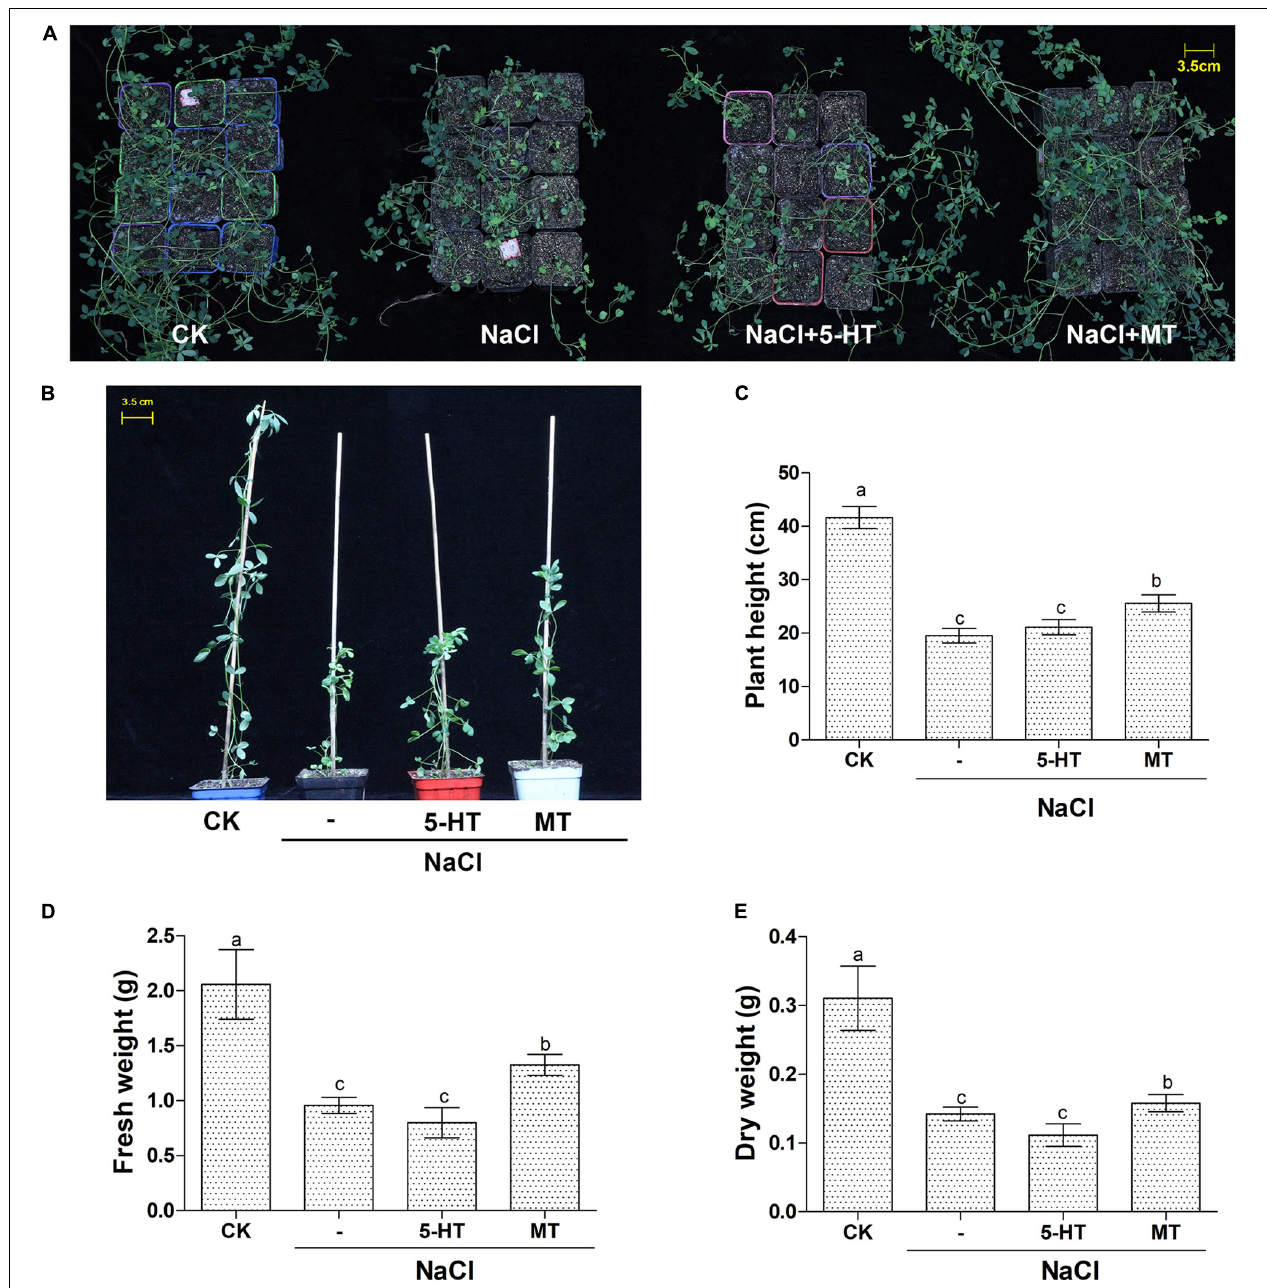
FIGURE 4 | Overall features of soil-grown alfalfa seedlings upon MT and 5-HT treatment with salt stress. Seedlings of alfalfa variety, Bingchi grown in soil pot, were irrigated with 137 mM NaCl for 14 days and were then treated with 150 µ M MT or 1 µ M of 5-HT together with NaCl, respectively. On the 30th day post-treatments, the pot-grown seedling (A) and representative individuals (B) from each group were photographed. Scale bar was shown. At least 20 individuals were measured for plant height (C) , fresh weight (D) , and dry weight (E) . Error bars show the SE between biological replicates and a t -test was performed between different treatment groups. Different numbers indicated significant differences ( p (cid:53) 0.05) between